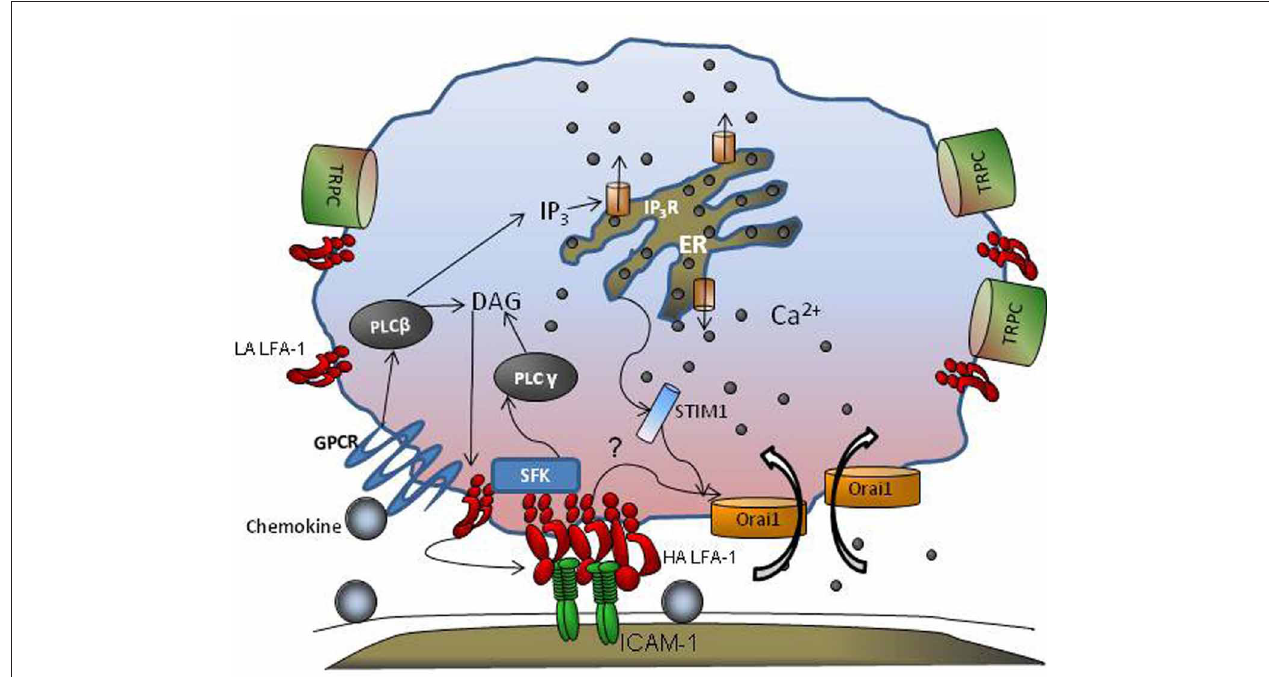
FIGURE 1 | GPCR and CRAC cooperate during leukocyte adhesion. Engagement of GPCRs by chemokines activates PLC β that is cleaved into DAG and IP 3 . While DAG remains membrane bound, IP 3 is released into the cytosol that then binds to IP 3 receptors in the endoplasmic reticulum (ER) liberating stores and leading to a rise in cytosolic Ca 2 + concentration. Integrin receptors shift from low affinity (LA) to high affinity (HA) in response to GPCR and increase their mobility in the membrane. STIM1 senses ER store depletion, binds to the ER membrane, and provides an anchor for